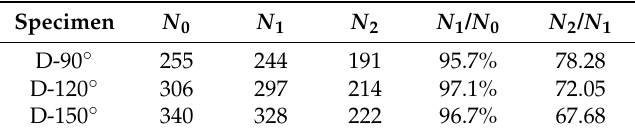
Figure 5. Interception situation of target plate and the related statistics of fragments. ( a ) Interception situation of D-90 ◦ ; ( b ) fragment statistics of D-90 ◦ ; ( c ) interception situation of D-120 ◦ ; ( d ) fragment statistics of D-120 ◦ ; ( e ) interception situation of D-150 ◦ ; ( f ) fragment statistics of D-150 ◦ . Table 2. Relationships between N 0 , N 1, and N 2